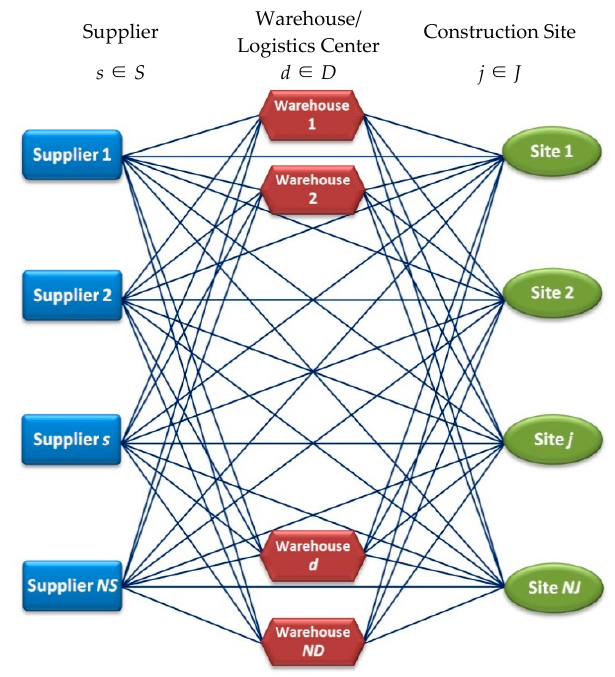
Figure 1. The proposed CSC Network Structure